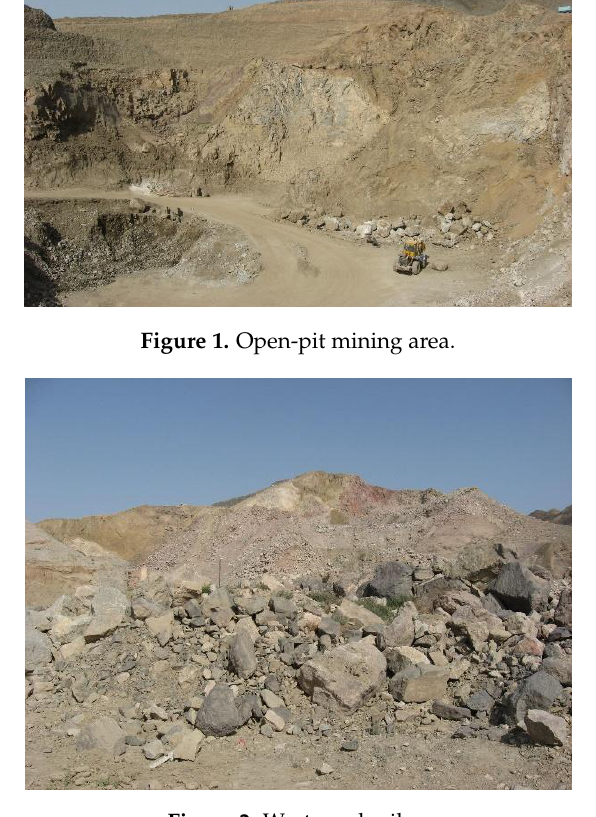
Figure 2. Waste rock piles.